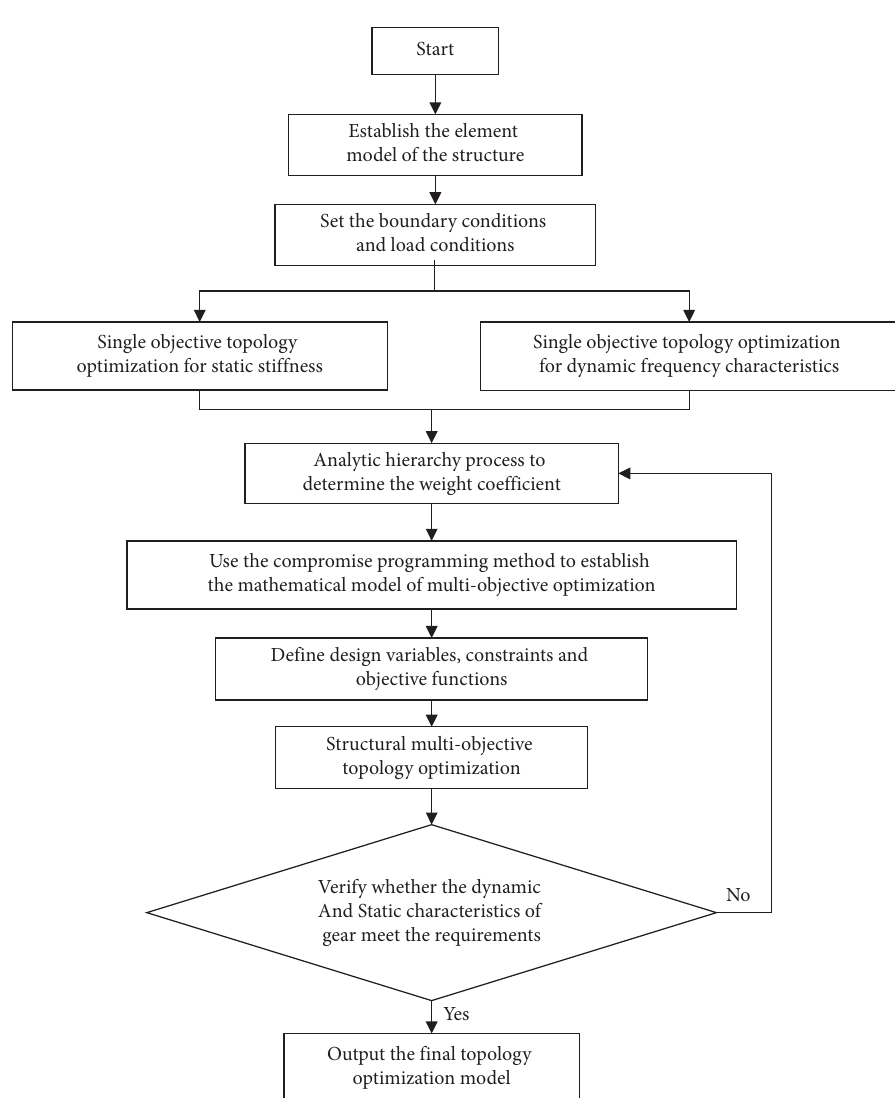
Figure 1: Schematic of the topology optimization